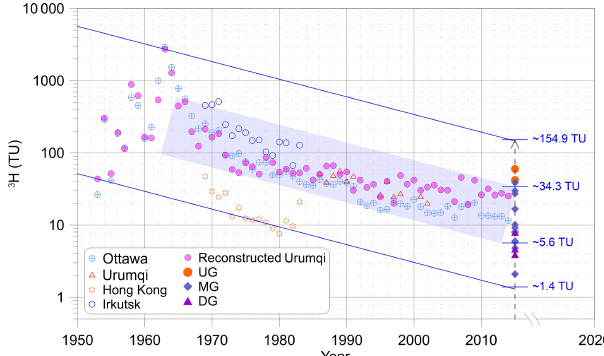
Figure 4. Tritium concentration (TU) of the upstream groundwater (UG), midstream groundwater (MG), and downstream groundwater (DG). Time series of tritium concentration in precipitation at Ot- tawa, Urumqi, Hong Kong, and Irkutsk were obtained by GNIP in IAEA (https://www.iaea.org/, last access: 4 December 2017). The blue solid lines and shaded field were drawn using the half-life (12.32 years) of tritium decayed to